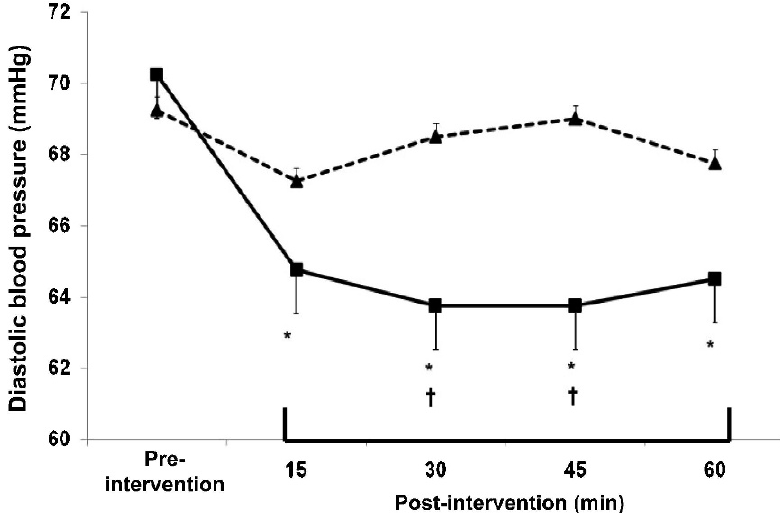
Figure 2 - Diastolic blood pressure measured pre-intervention, and at 15, 30, 45 and 60 minutes after the interventions in the control (dashed line with triangles) and the resistance exercise (solid line with squares) sessions. * Significantly different from pre-intervention (P , 0.05). { Significantly different from the control session (P ,